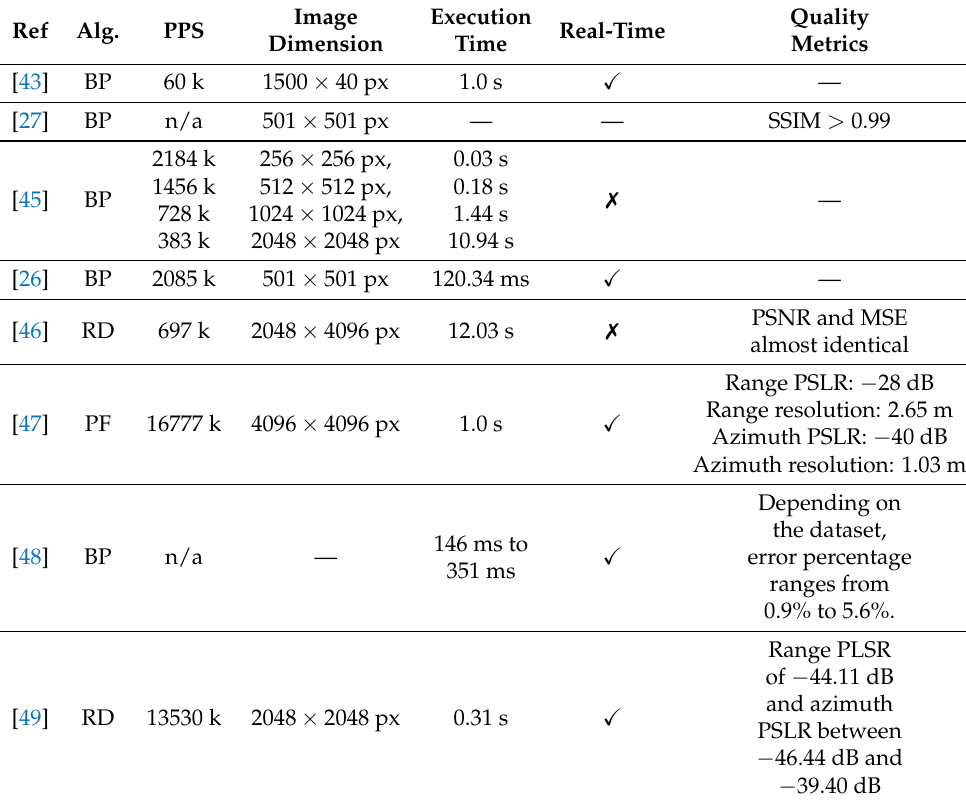
Table 8. Comparison between the different hardware implementations of SAR image formation algorithms, described in Section 4.4. This table includes the algorithm, execution time and average pixels per second (PPS), whether the work is real-time or not, image dimensions and quality metrics. Notes marked with an asterisk are displayed in the last column of Table 9, named